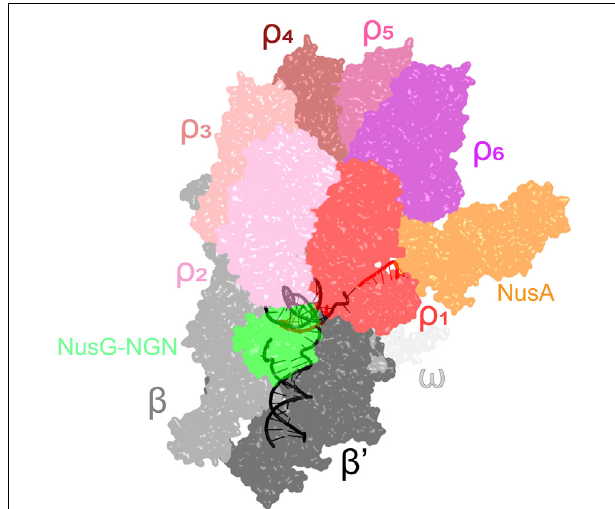
FIGURE 4 | A cryo-EM structure of the Rho engagement complex, in which Rho hexamer makes initial contacts with the transcribing RNAP bound to NusA and NusG. The DNA is shown in black; the RNA—in red. PDB ID: